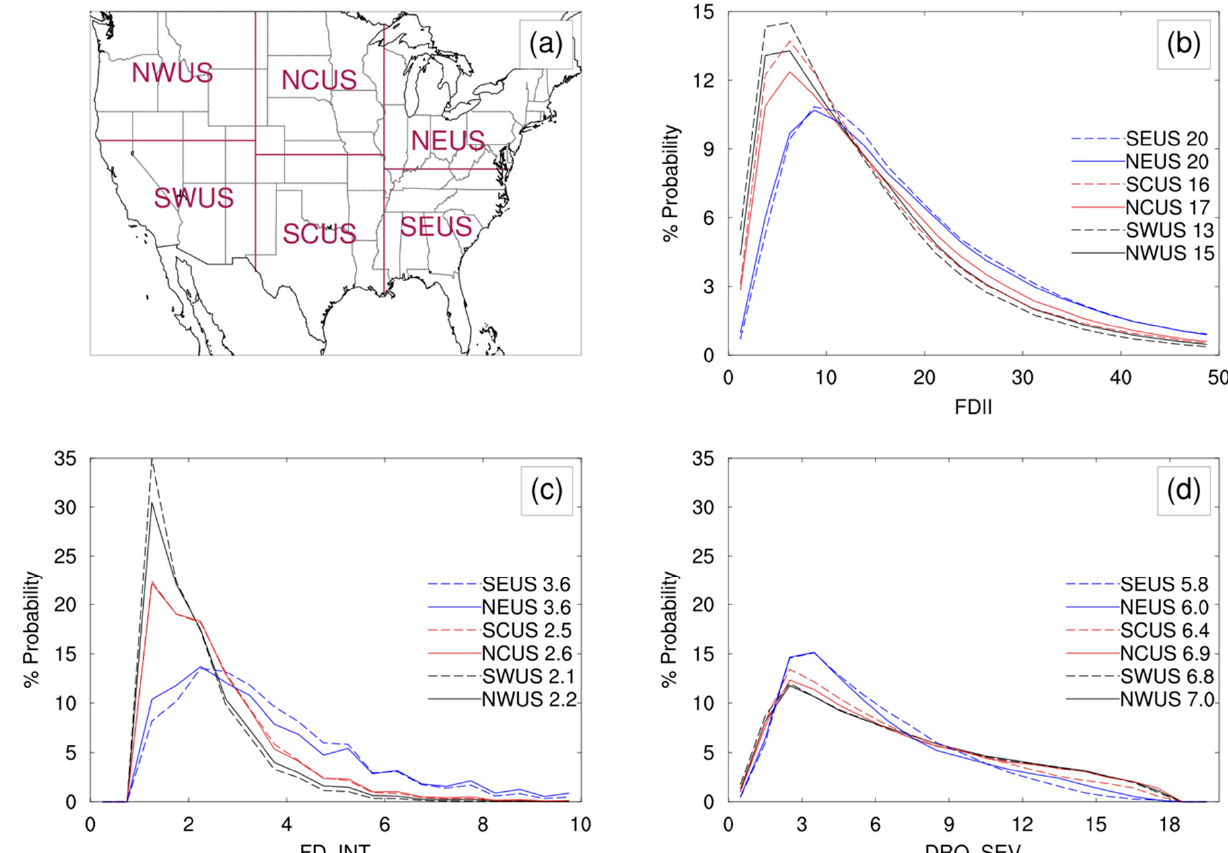
Figure 3. ( a ) Map showing the six regions that were used to compute probability density functions for ( b ) FDII, ( c ) FD_INT, and ( d ) DRO_SEV using pentad data from April–October during 1979–2017. The mean value for each regional distribution is also shown on each panel. The distributions and mean values were computed using data from individual pentads and grid points for which flash drought occurred.